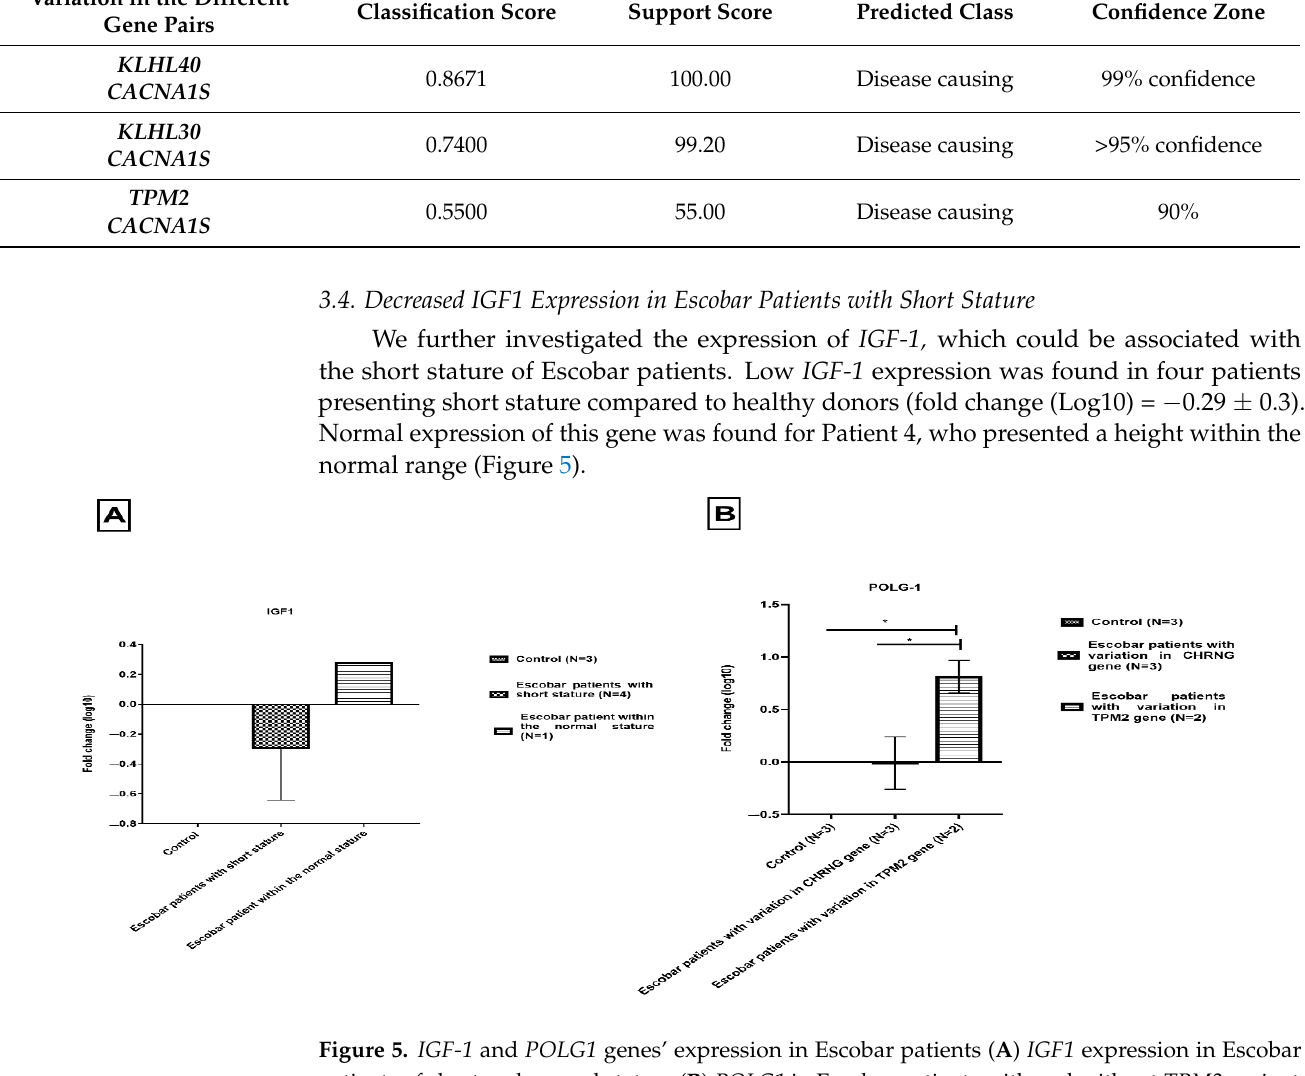
Figure 5. IGF-1 and POLG1 genes’ expression in Escobar patients ( A ) IGF1 expression in Escobar patients of short and normal stature ( B ) POLG1 in Escobar patients with and without TPM2 variant . Data are presented as Log10 fold change. Results are presented as mean ± standard error for qPCR normalized to 2 housekeeping genes RPLP0 and PPIA (* p < 0.5) .